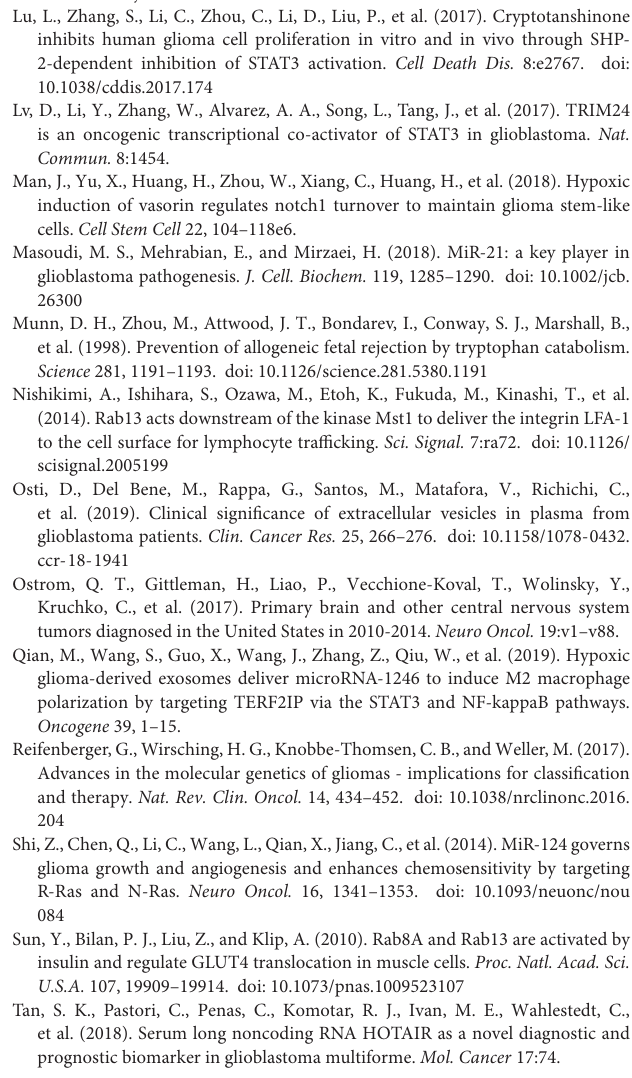
Supplementary Figure 1 | The relationship between the expression of PLEKHG48 and the diagnosis and prognosis of patients with glioma. Supplementary Table 1 | The detailed sequence of